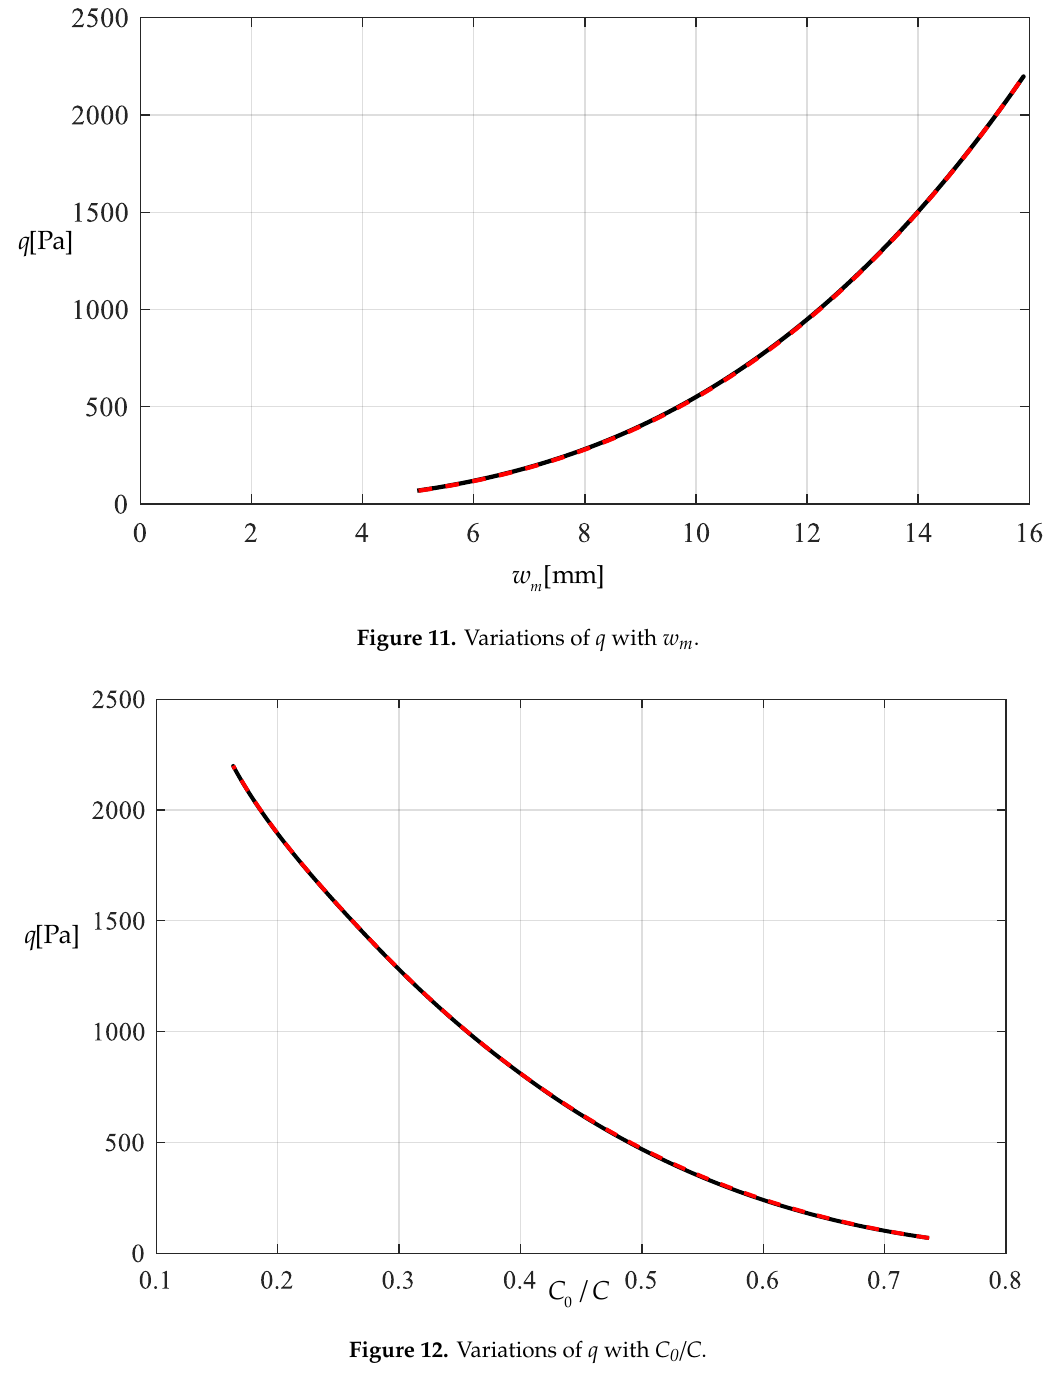
Figure 12. Variations of q with C 0 / C .